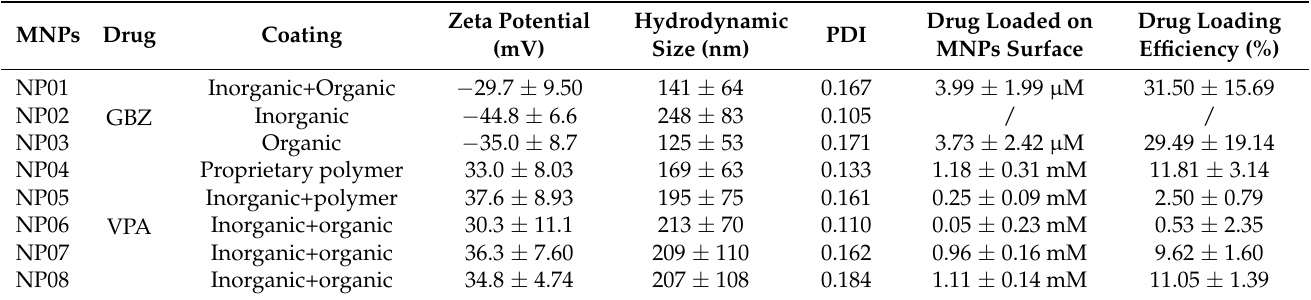
Table 1. Physicochemical properties and drug loading efficiency of the MNPs. PDI = polydispersity index. The inorganic coating corresponds to TEOS; the organic coating corresponds to citric acid; inorganic+organic corresponds to a mix of TEOS with other